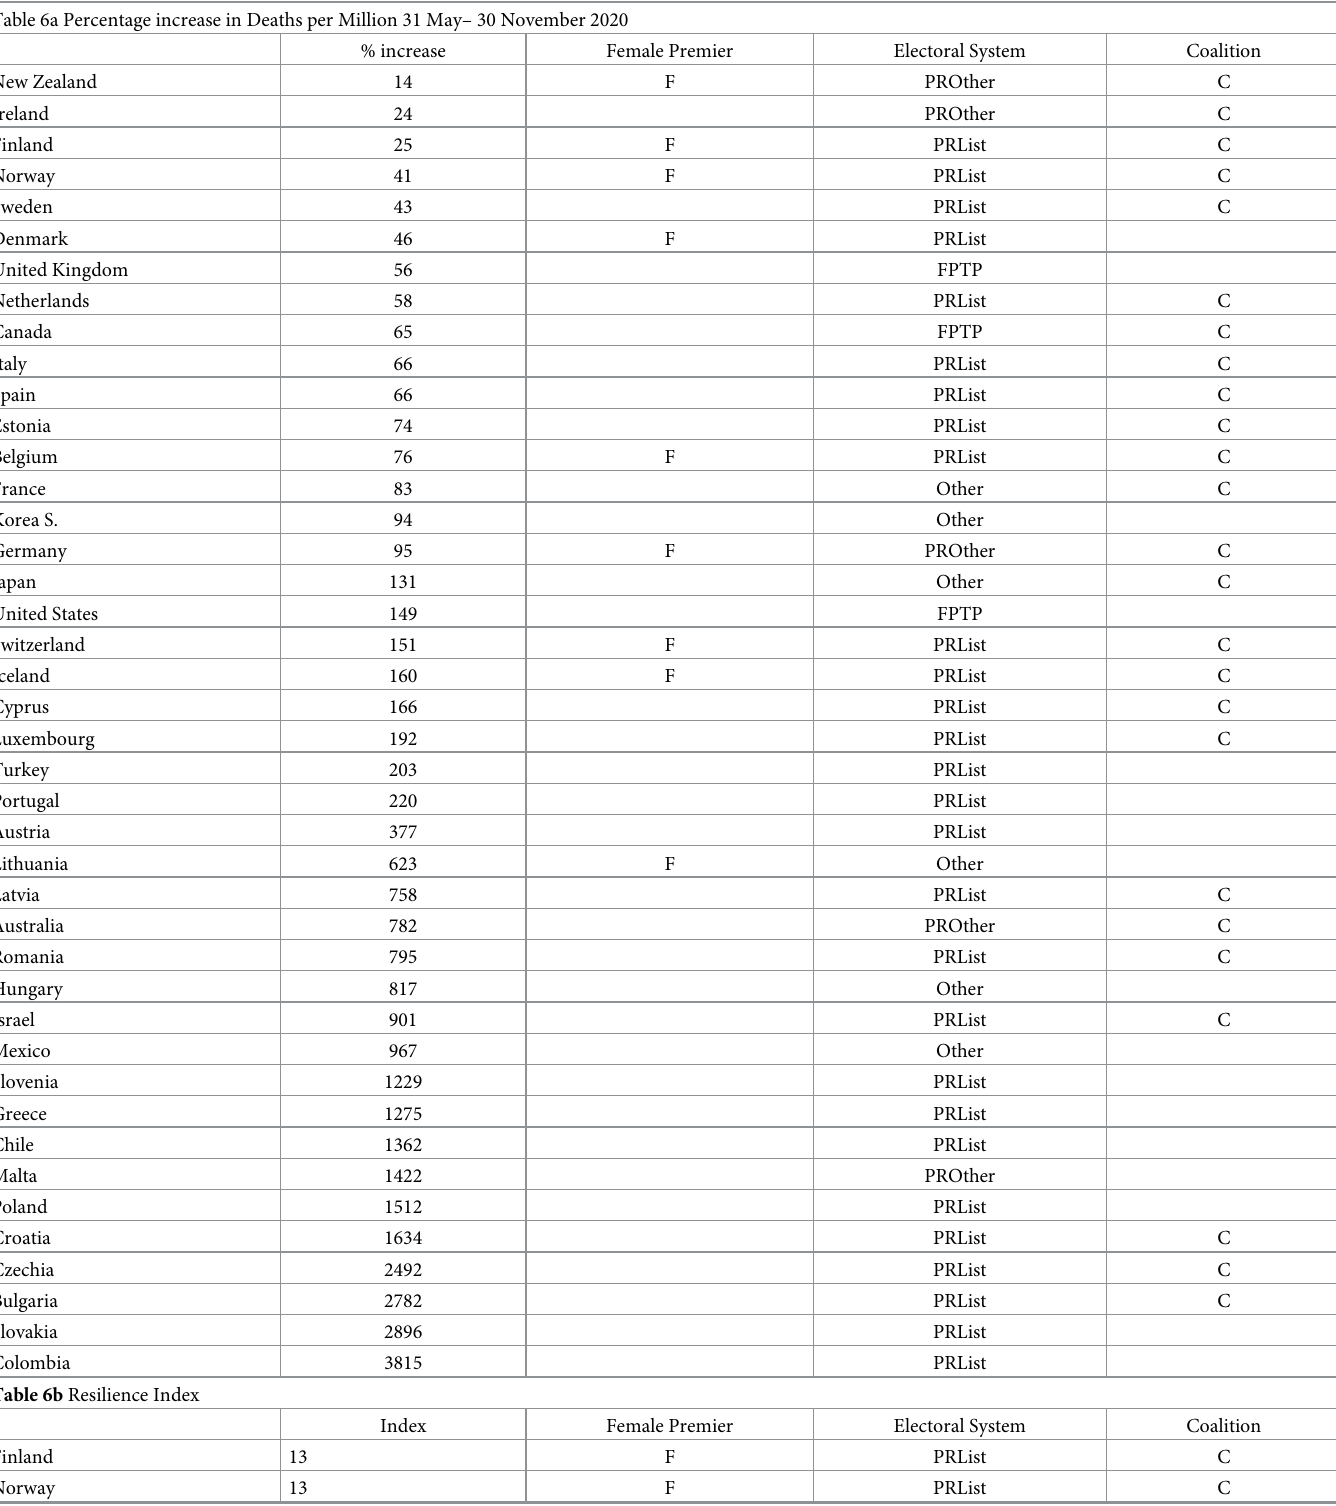
Table 6. Political characteristics. Table 6a Percentage increase in Deaths per Million 31 May– 30 November 2020